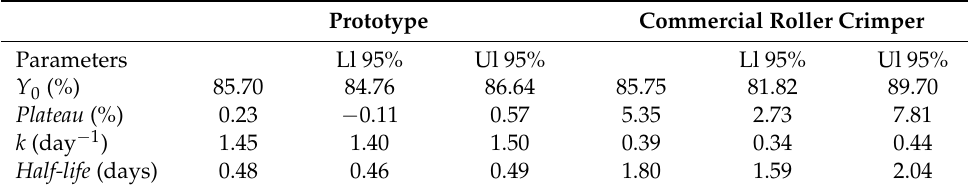
Table 3. Main parameters of the monophasic exponential nonlinear regression curves.